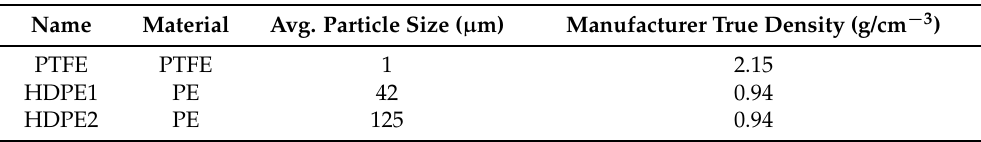
Table 1. Three polymer materials used for pellet fabrication, with particle size and solid true density at 25 °C provided by the material